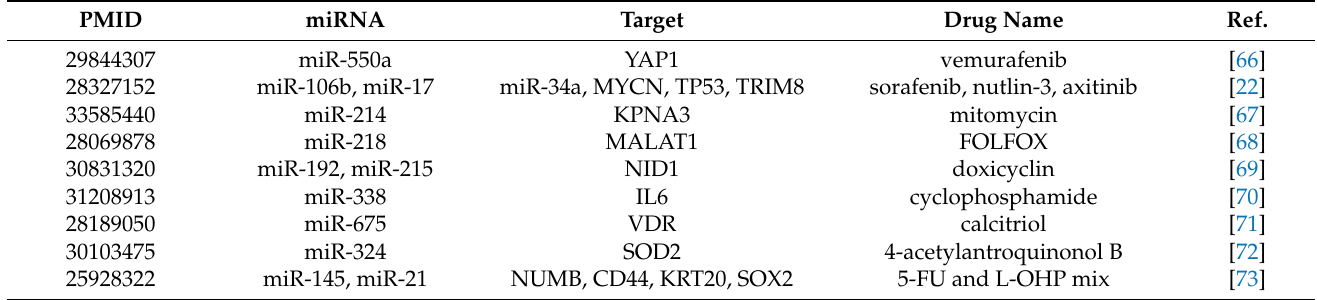
Table 1. List of miRNA target interactions and relative drugs not included in the Figure 1 networks. PMID miRNA Target Drug